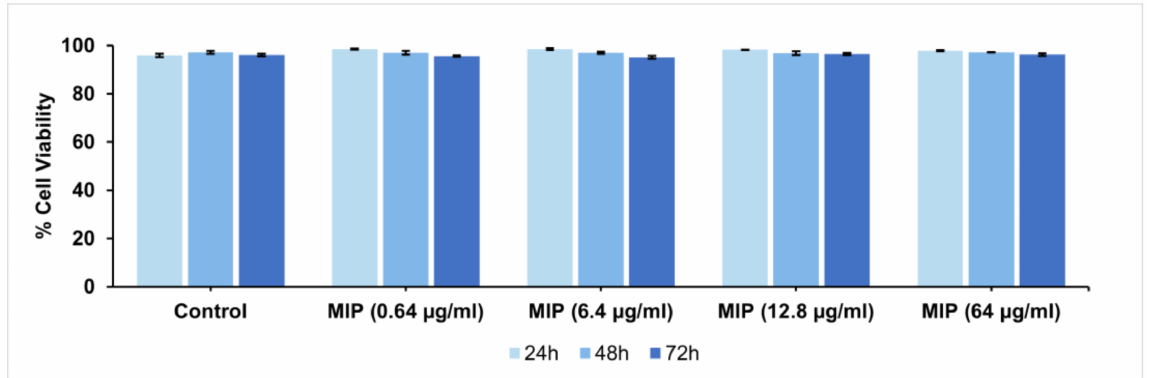
Figure 7. Cytocompatibility analyses of MIPs with H9C2 at 24, 48, and 72 h, evaluated by propidium iodide flow cytometry (mean ± SD; MIPs: n = 6). Negative control: cells seeded without